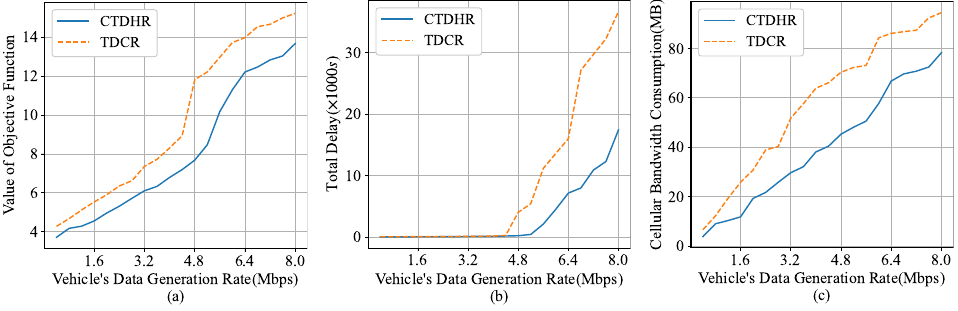
Figure 6. ( a – c ) The comparisons of CTDHR and TDCR for objective function results, total delay, and cellular network bandwidth consumption,